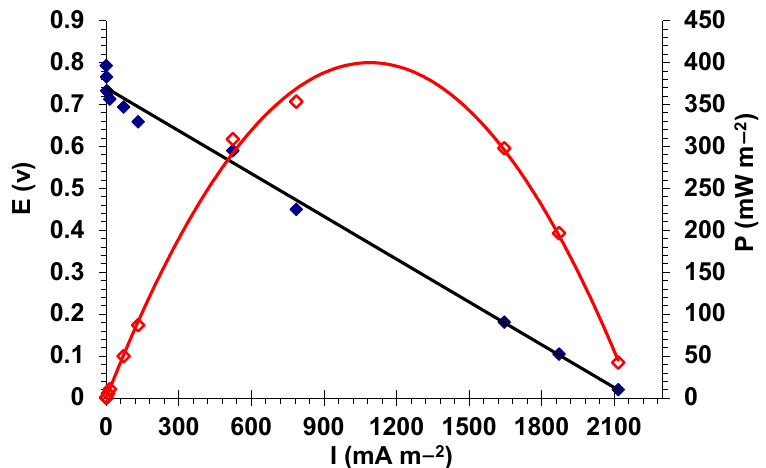
Figure 6. Power density and Polarization curves of MFCs with ZrP 2 O 7 catalyst.